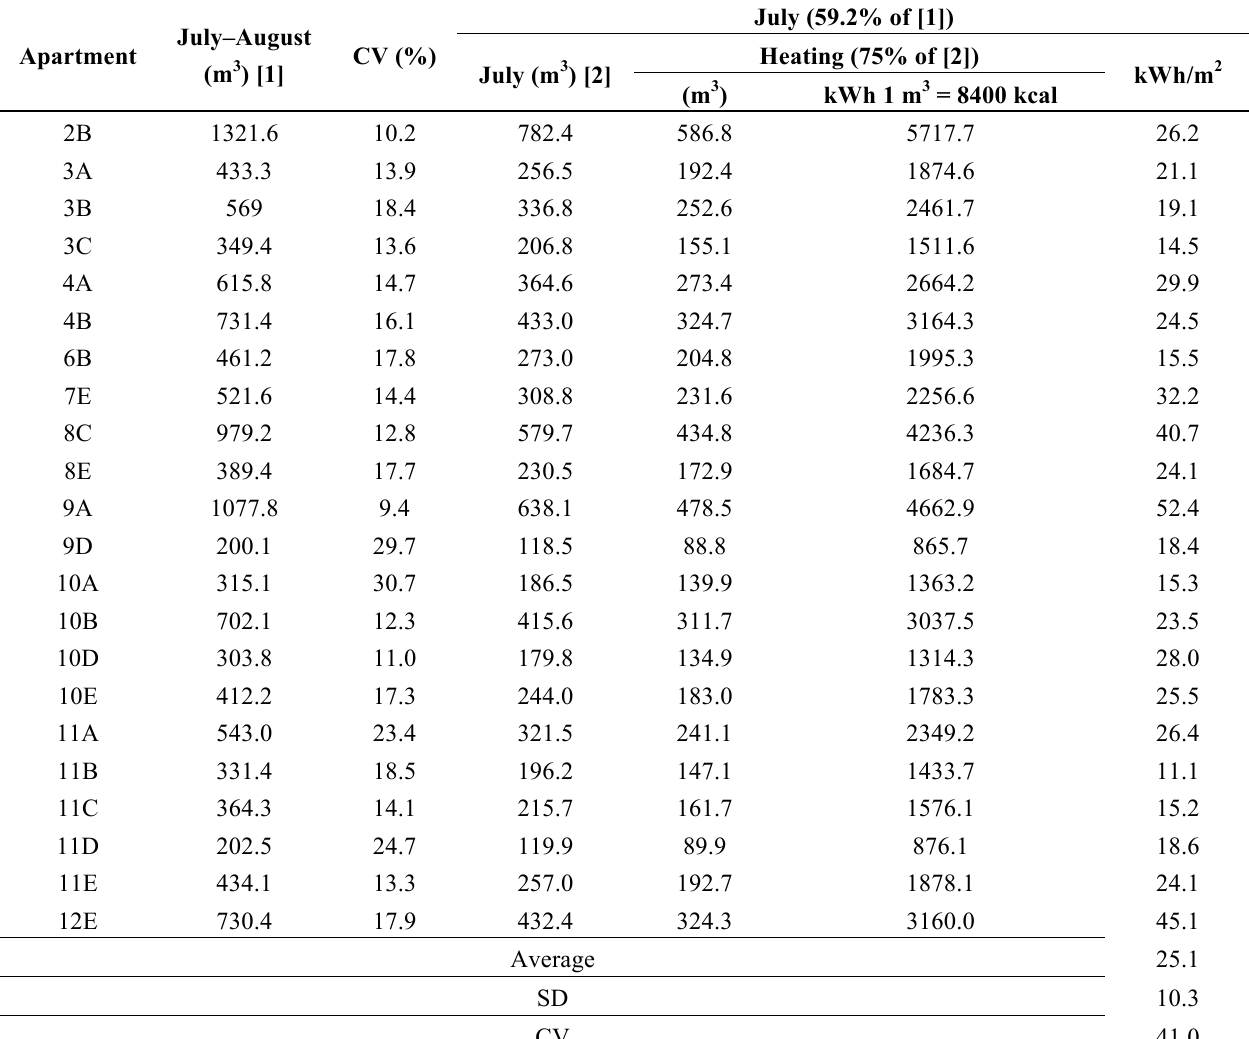
Table 5. Average and variability of historical heating gas natural consumption during July and August (period = 1996–2008).